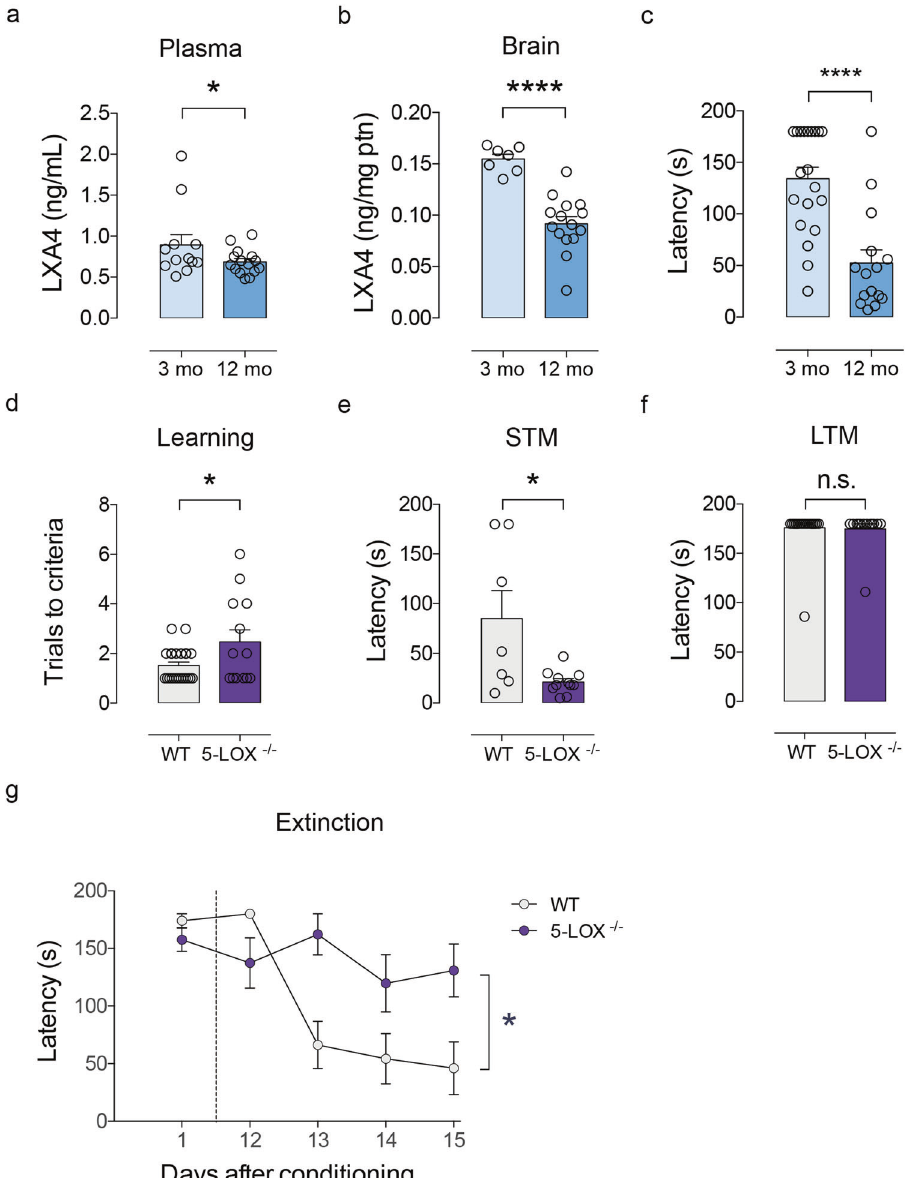
Fig. 2 Age-linked reductions in LXA4 result in cognitive impairment. a , b Levels of lipoxin A4 (LXA4) in plasma ( a ) and brain ( b ) of young (3 month old) or aged (12 month old) Swiss mice. (Plasma: N = 12 for 3 mo, N = 15 for 12 mo; Brain: N = 7 for 3 mo, N = 15 for 12 mo mice). c Step-down latency of young or aged mice in the inhibitory avoidance task to assess short-term memory (STM: 1 h after training; N = 20 for 3 mo; N = 15 for 12 mo mice). d Number of trials required for each mouse to reach the criteria during the training session in the inhibitory avoidance fear task ( N = 23 for WT; N = 13 for 5-LOX − / − ). e , f Step-down latency of 5-LOX − / − or WT mice (3 month old) in the inhibitory avoidance task to assess short-term ( e ; STM: 1 h after training; N = 7 WT and N = 15 5-LOX − / − mice) or long-term memory ( f ; LTM: 24 h after training; N = 23 for WT; N = 13 for 5-LOX − / − ). For a , b , and d , two-tailed unpaired Student ’ s t -test. For c , e , and f , two-tailed unpaired Mann – Whitney (* p < 0.05; **** p < 0.0001). Graphs show means ± standard error of the mean (SEM). Each dot represents an individual. g Fear memory extinction assessed by step-down latency of 5-LOX − / − or WT after repeated test sessions 12 – 15 days after original conditioning session ( N = 10 WT and N = 10 5-LOX − / − mice). Repeated measures one-way ANOVA with Š idák post hoc test (* p < 0.05). Graphs show means ±